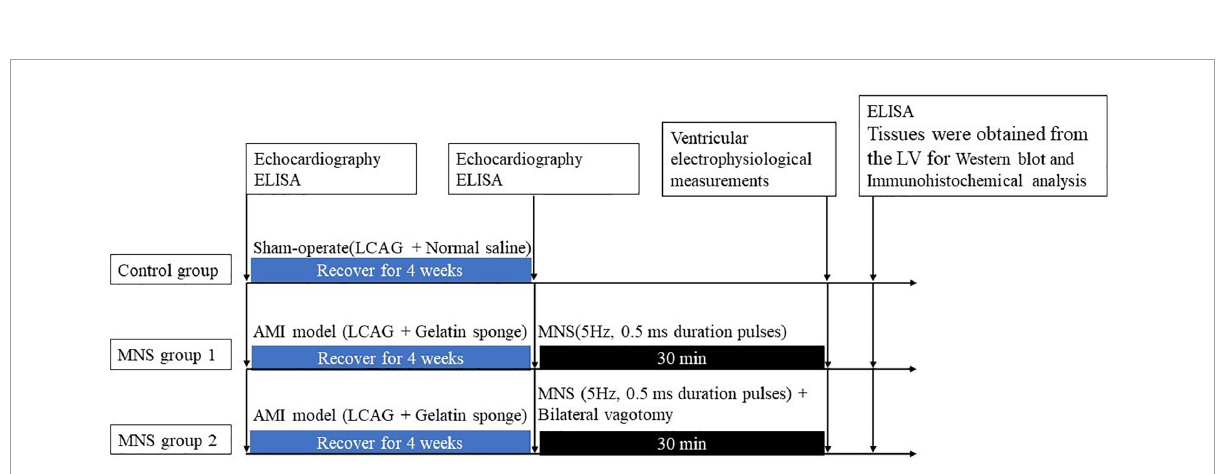
FIGURE2 Median nerve stimulation protocol and time axis of procedures used in this study. LV, left ventricle; AMI, acute myocardial ischemia; LCAG, left coronary angiography; MNS, median nerve stimulation.